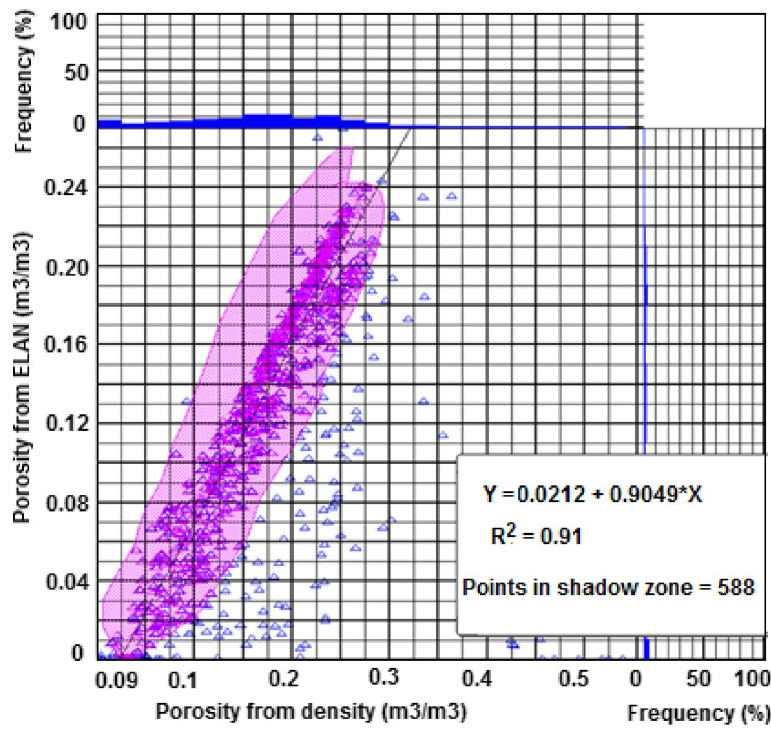
Fig. 4 ELAN interpretation and permeability prediction in Well-B